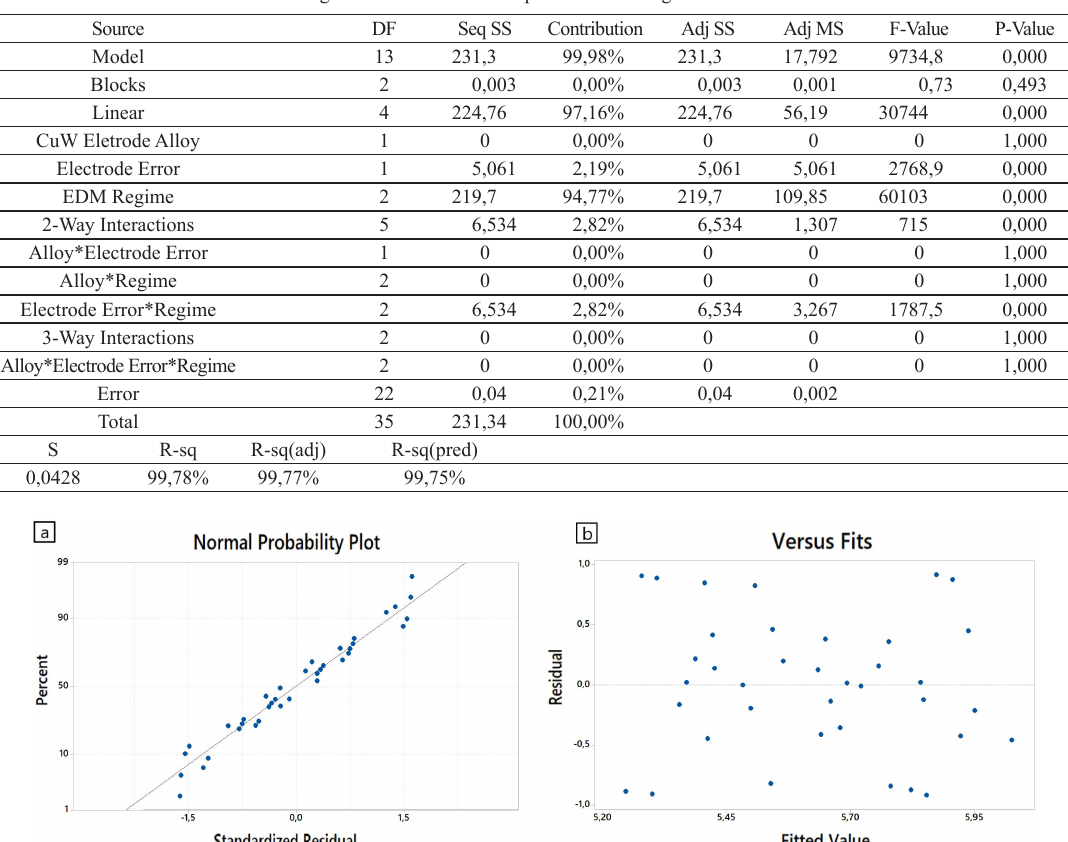
Table 5. ANOVA table for ED-Machining effects on WC-Co workpiece surface roughness.